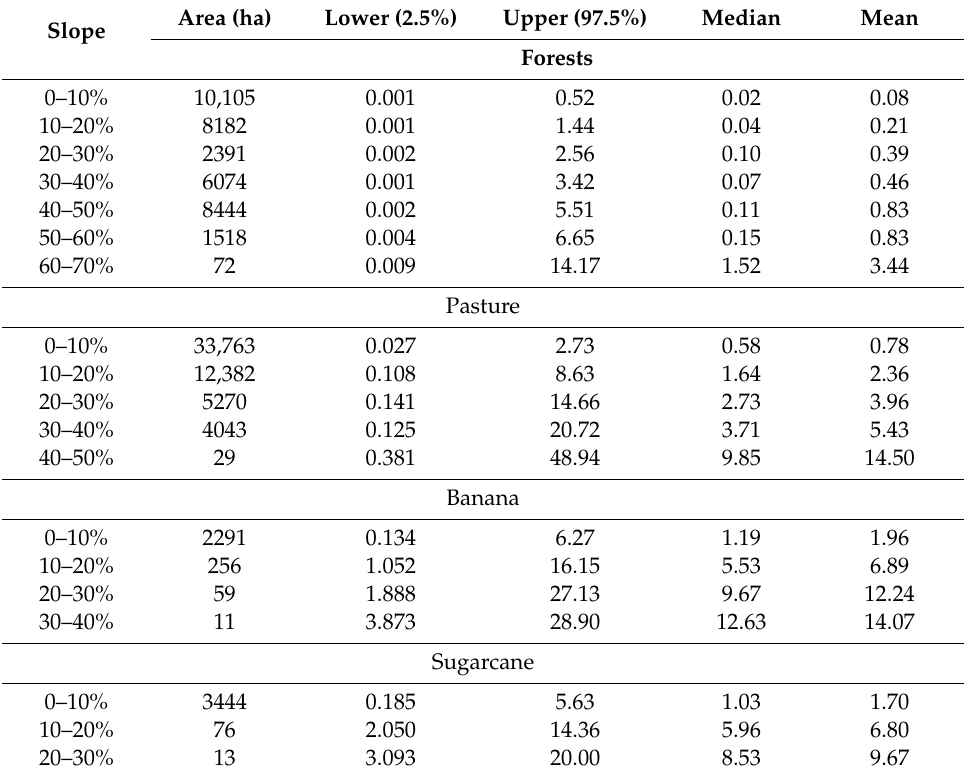
Table 5. The 95PPU, median and mean of soil erosion rate (t · ha –1 · year − 1 ) in major land uses for the simulation period (1991–2012) classified based on slope